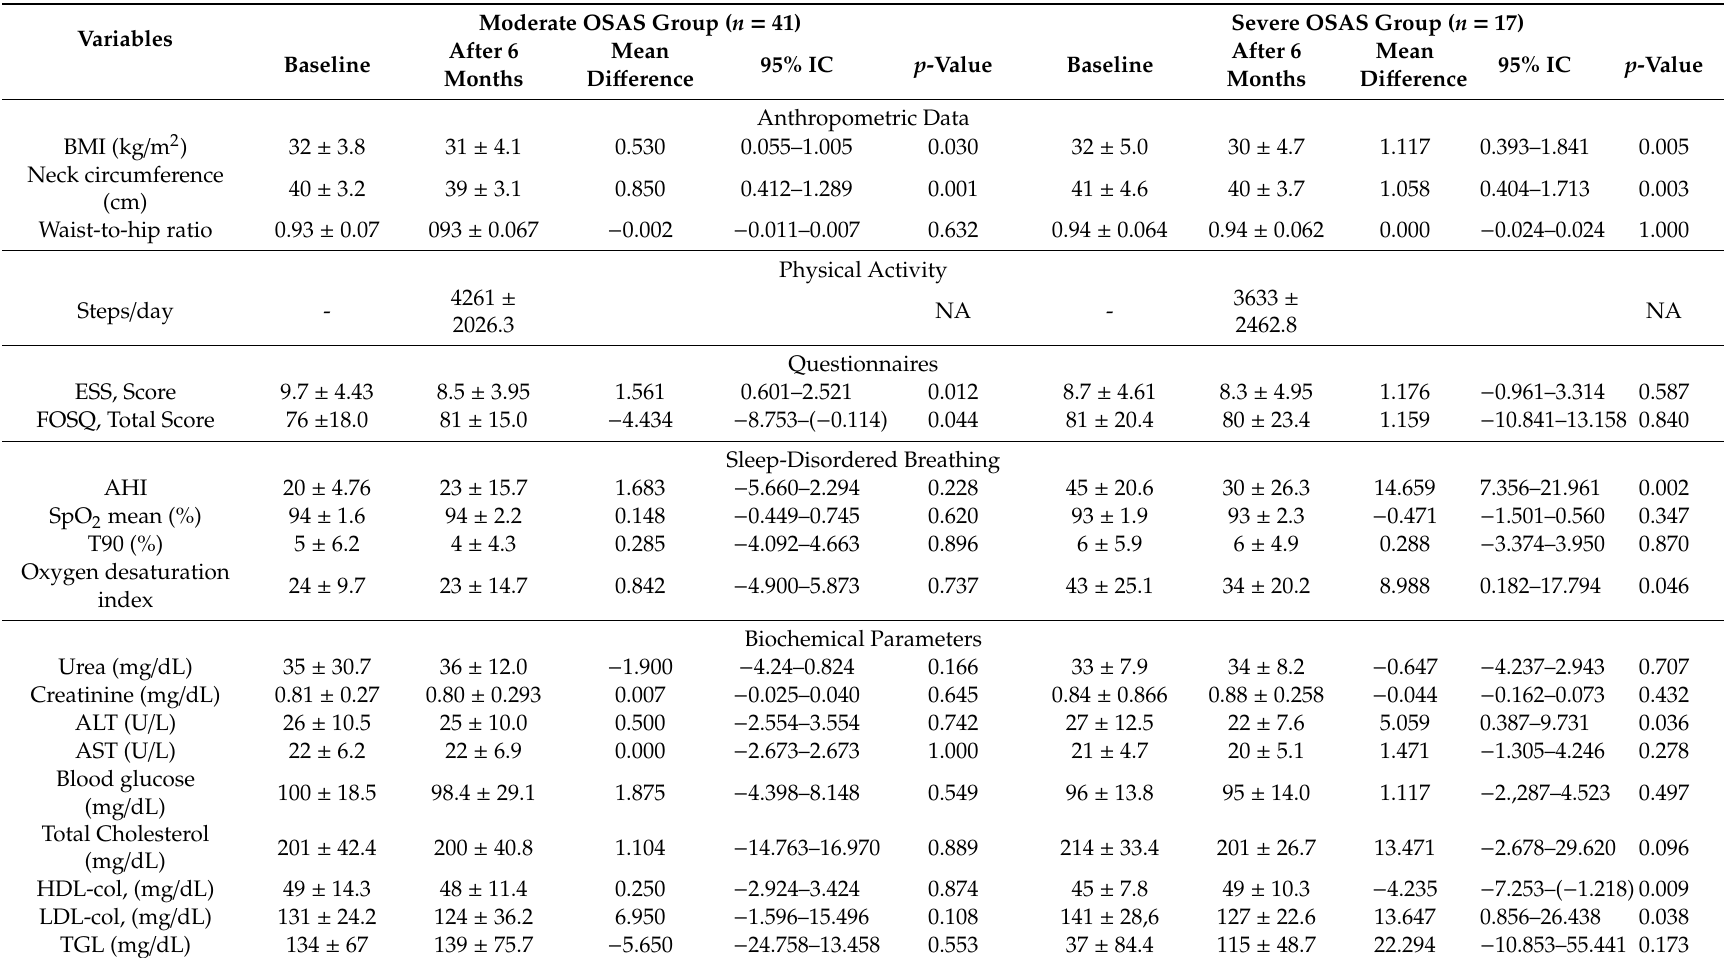
Table 3. Impact of the physical exercise program analyzed by OSAS